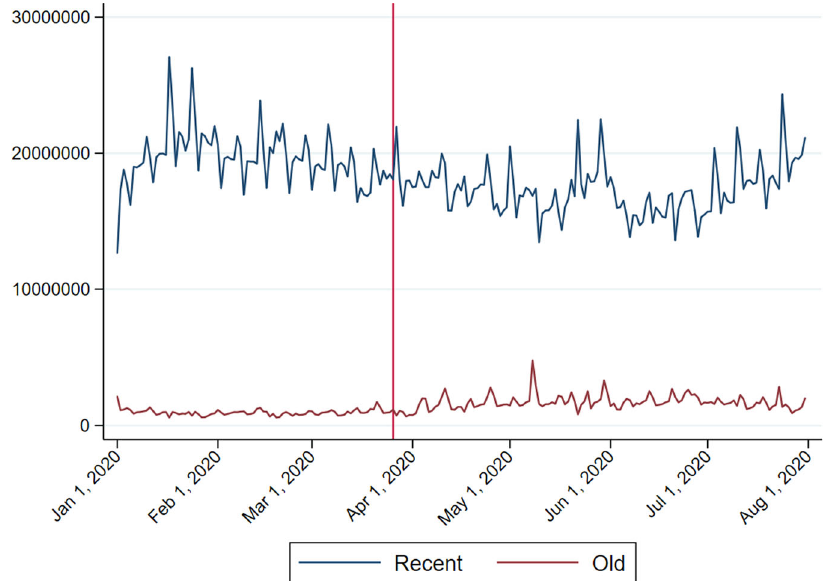
Fig. 1 UK daily number of plays (top 200 only), January – July 2020. Note : The vertical reference line indicates the beginning of the lockdown on 26 March 2020. Source : Spotify.